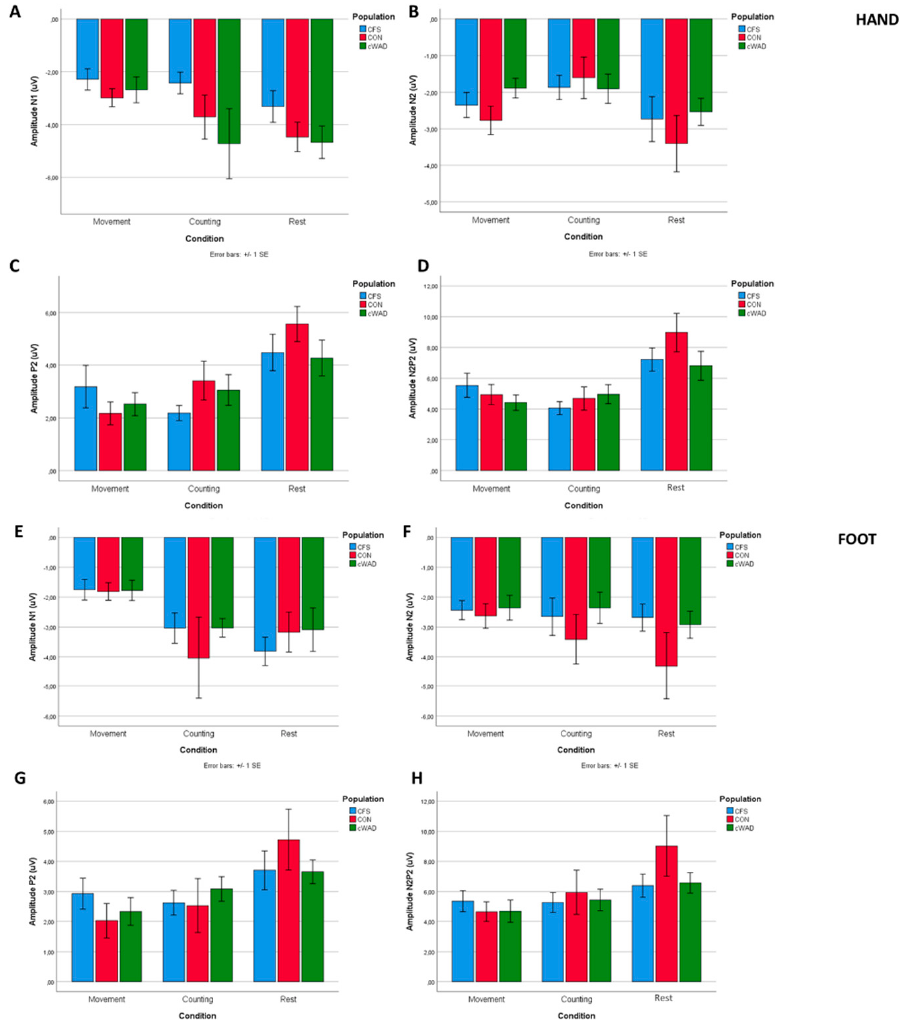
Figure 4. Group-level average magnitude of (LEP) components, separated by type of condition, location and population for nociceptive laser stimulation. Bar plots show the average amplitude of each LEP component. Note that there were no statistically significant di ff erences between populations. ( A ) Magnitude of N1 component for hand stimulation. A significant e ff ect of conditions was found between rest versus movement and between counting versus movement. ( B ) Magnitude of N2 component for hand stimulation. A significant e ff ect of conditions was found between rest versus counting, rest versus movement and between counting versus movement. ( C ) Magnitude of P2 component for hand stimulation. A significant e ff ect of conditions was found between rest versus counting and between rest versus movement. ( D ) Magnitude of N2P2 component for hand stimulation. A significant e ff ect of conditions was found between rest versus counting and between rest versus movement. ( E ) Magnitude of N1 component for foot stimulation. A significant e ff ect of conditions was found between rest versus movement and between counting versus movement. ( F ) Magnitude of N2 component for foot stimulation. ( G ) Magnitude of P2 component for foot stimulation. A significant e ff ect of conditions was found between rest versus counting and between rest versus movement. ( H ) Magnitude of N2P2 component for foot stimulation. A significant e ff ect of conditions was found between rest versus counting and between rest versus movement. Abbreviations: CFS: chronic fatigue syndrome, cWAD: chronic whiplash associated disorders, HC: healthy controls. Two-factor mixed ANOVAs were performed to reveal di ff erences in LEP amplitudes and latencies between the three conditions (resting versus counting versus movement preparation) and population (HC versus CFS versus cWAD) (Table 3).